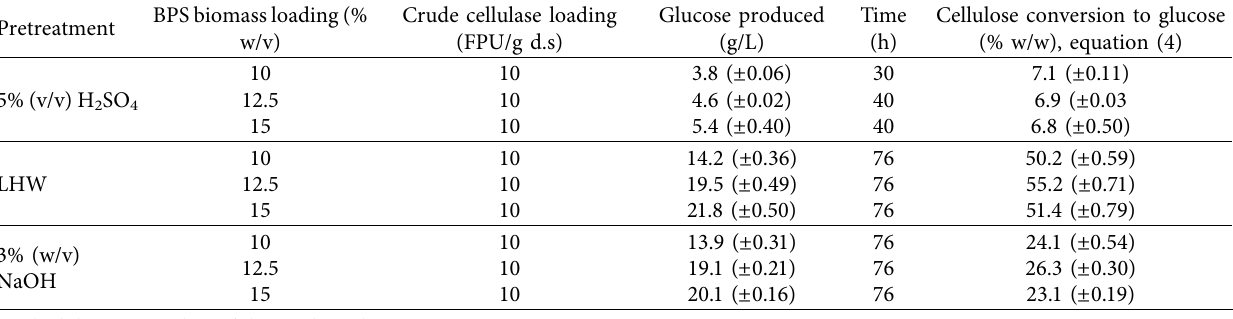
Standard deviation ± values of three independent repeats.